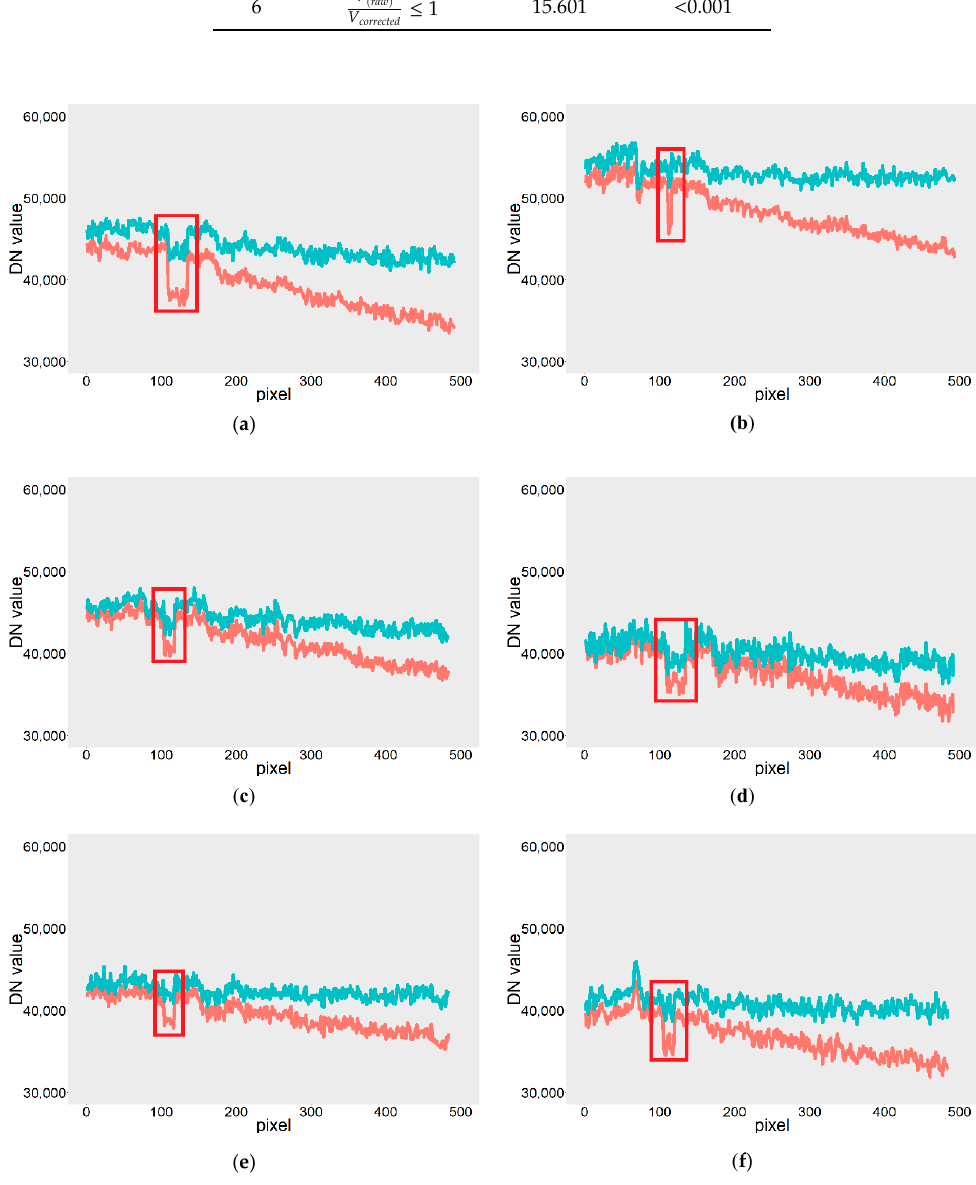
Figure 17. Digital numberss (DNs) extracted along profile from raw image (red lines) and corrected image (blue lines): ( a ) Band 1; ( b ) Band 2; ( c ) Band 3; ( d ) Band 4; ( e ) Band 5; ( f ) Band 6. The coe ffi cient of variation was reduced from 8.14% to 3.55% in Band 1 ( a ); from 6.25% to 2.08% in Band 2 ( b ); from 6.05% to 3.09% in Band 3 ( c ); from 6.78% to 3.63% in Band 4 ( d ); from 5.04% to 2.16% in Band 5 ( e ); from 6.45% to 2.68% in Band 6 ( f ). There is also visible reduction e ff ect of DNs errors caused by random non-uniform quantum e ffi ciency (red